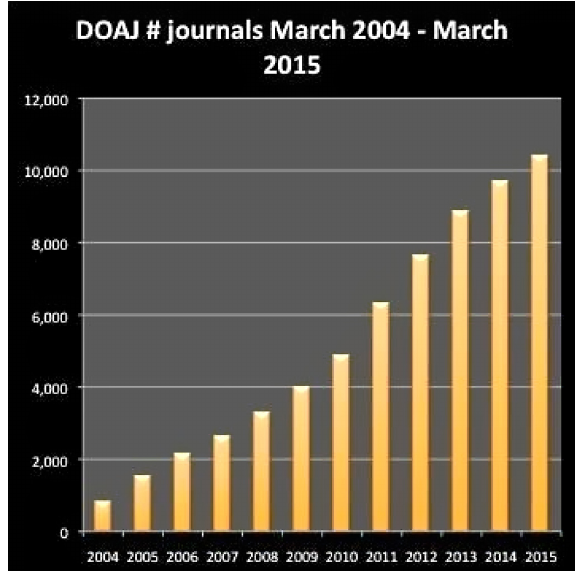
Figure 1. The number of journals in DOAJ from March 2004 to March 2015. Source: Heather Morrison: Dramatic Growth of Open Access series, The Imaginary Journal of Poetic Economics: http://poeticeconomics.blogspot.ca/2015/04/dramatic-growth-